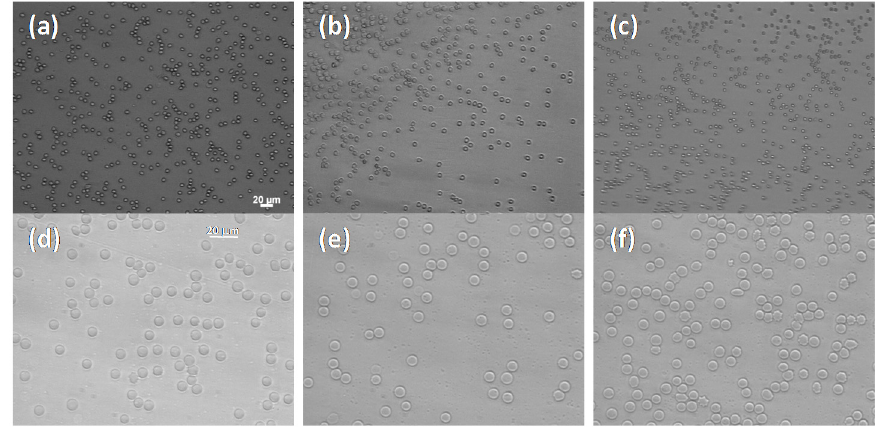
Figure 8. Optical micrographs of: RBC cells alone ( a , d ); and in the presence of FNPs (0.01 wt %) at: 10% Hct ( b , e ); or 15% Hct ( c , f ). Images ( a – c ) are at magnification 20 × , while ( d – f ) are at magnification 40 ×.